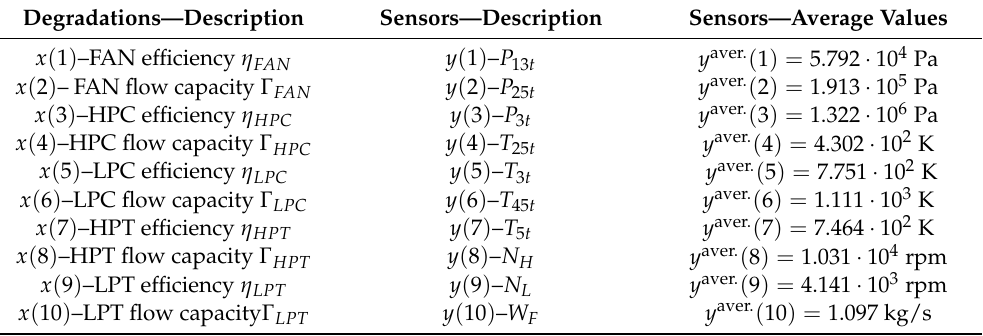
Table 1. Degradations ( x ) and sensors ( y ) descriptions, and average values of the sensor outcomes using the default set of sensors (defined below) for the specific aeroengine formulation considered in Section